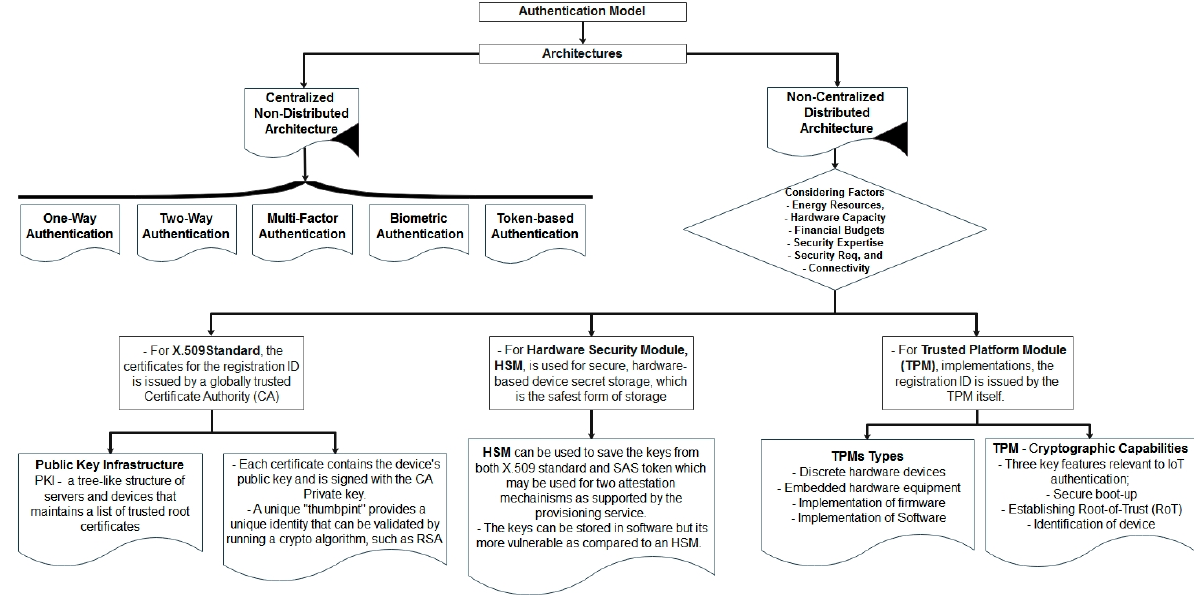
Figure 4. Authentication Model.